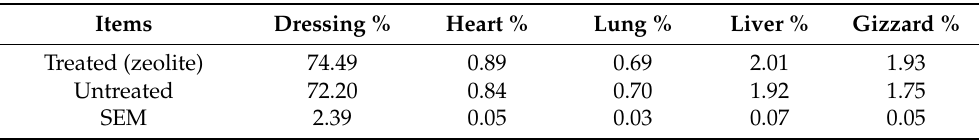
Table 7. Least square means for dressing % and relative organs as affected by treatment, line, and sex